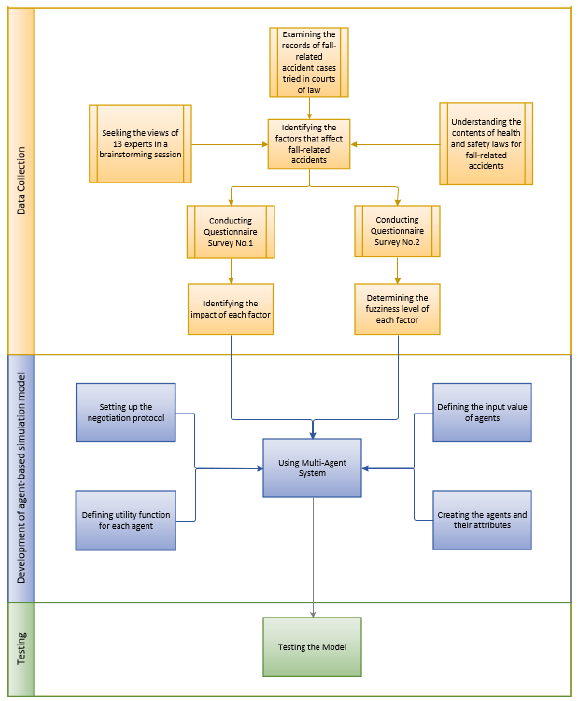
Figure 1. Flow Diagram of Research Method.